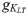
Simulating auditory responses with biophysical dynamics.(A) Auditory responses were simulated by convolving a spectrotemporal receptive field (upper left) with the spectrogram (upper right) of an auditory stimulus, in this case a zebra finch song. Black dashed lines indicate syllable boundaries. The resulting convolution (black line) provided the driving current (Istim(t)) to the single-compartment biophysical model used in this study (right). Red noise (bright red line) was added in each trial as a stimulus-independent current (Inoise(t)) with SNR of 4. The model was integrated to produce a simulated voltage trace (lower left). The conductance of a low-threshold potassium channel parameter (gKLT) was set to 0 nS for tonic dynamics (blue line) or 50 nS for phasic dynamics (dark red line). Voltage traces are vertically offset for better visibility. (B) Raster plots of the full simulation for the stimulus-RF pair in A across 10 trials for phasic (red) and tonic (blue) model. The example demonstrates how the phasic model produces more reliable and temporally precise responses than the tonic model.